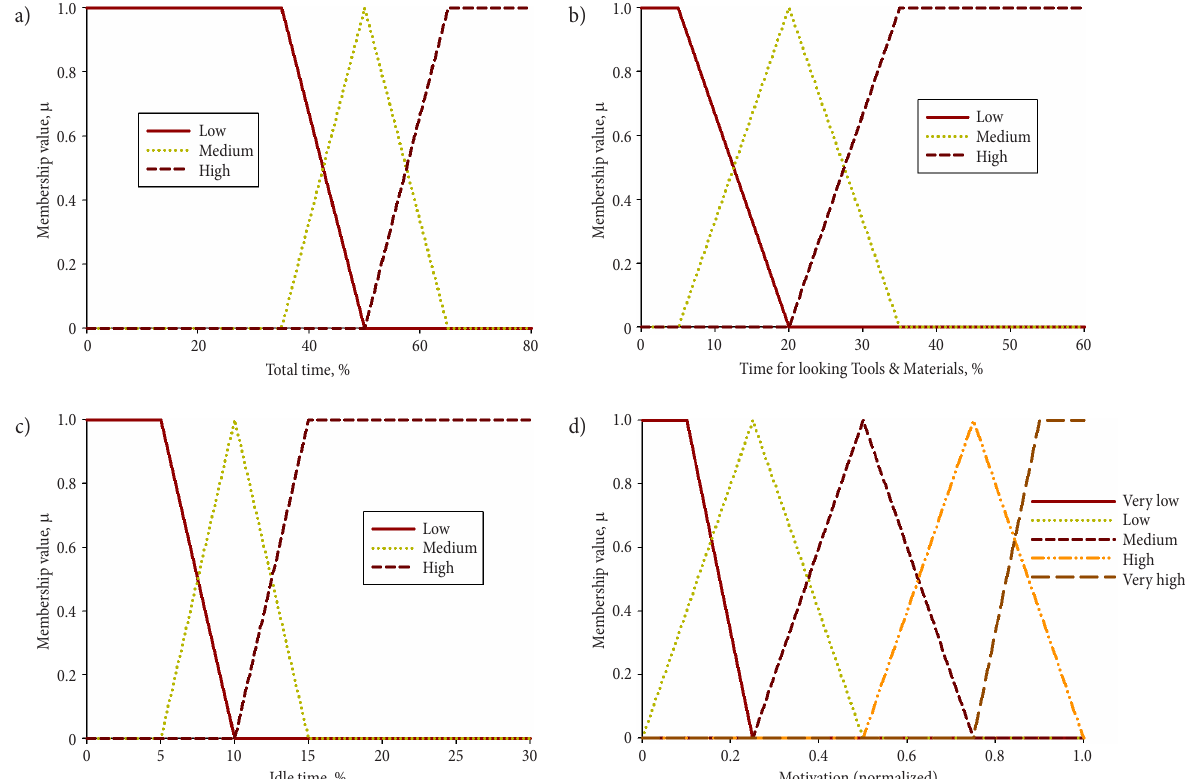
Fig. 2. Membership functions of input and output variables: (a) working (tool) time, (b) materials and tools searching time, (c) idle time, and (d)